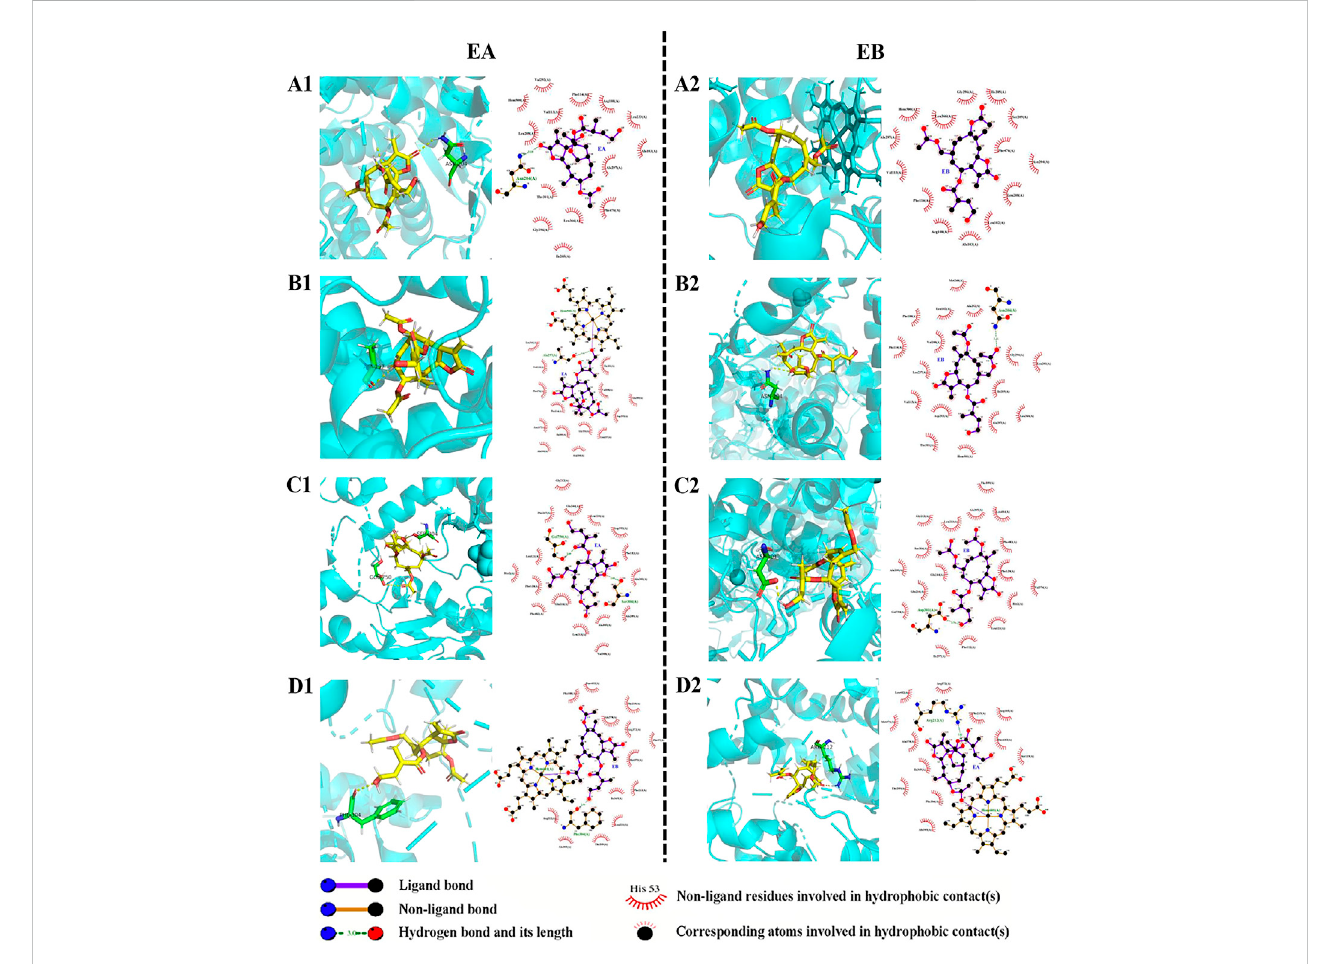
FIGURE 8 Interactions between EA (1) or EB (2) and CYP isoforms (left, 3D and right, 2D). (A) CYP2C9; (B) CYP2C19; (C) CYP2D6; (D) CYP3A4.